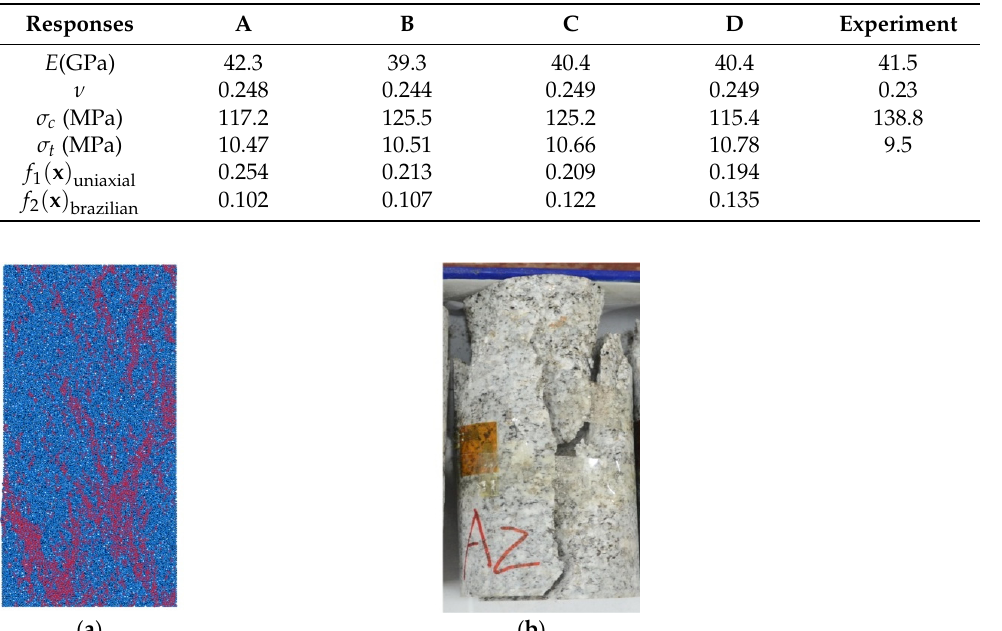
( b ) Figure 13. The material fractures under Brazilian splitting test. ( a ) DEM calculation with individual B; ( b ) Experiment. 4.2. Validation The validation for the inversed result is performed by DEM calculation under the three-point bending test. Firstly, according to the three-point bending test, the corre- sponding DEM model is established, as shown in Figure 14. In this model, the basic model parameters are the same as those in Section 3.2 and the parameter values of individual B are utilized. The boundary condition and loading are consistent with the experiment. Figure 14. A DEM model for three-point bending test. The result of the DEM calculation under the three-point bending test is given in Table 7. The computational response is very close to the experimental response and the relative error is 8.98%. Then, the fracture from the DEM calculation is shown in Figure 15, which compared with the experimental measurement. It can be found that the DEM simulation agrees well with the experiment. These results validate that the inversed results based on the present multi-objective identification technique are effective and reliable.